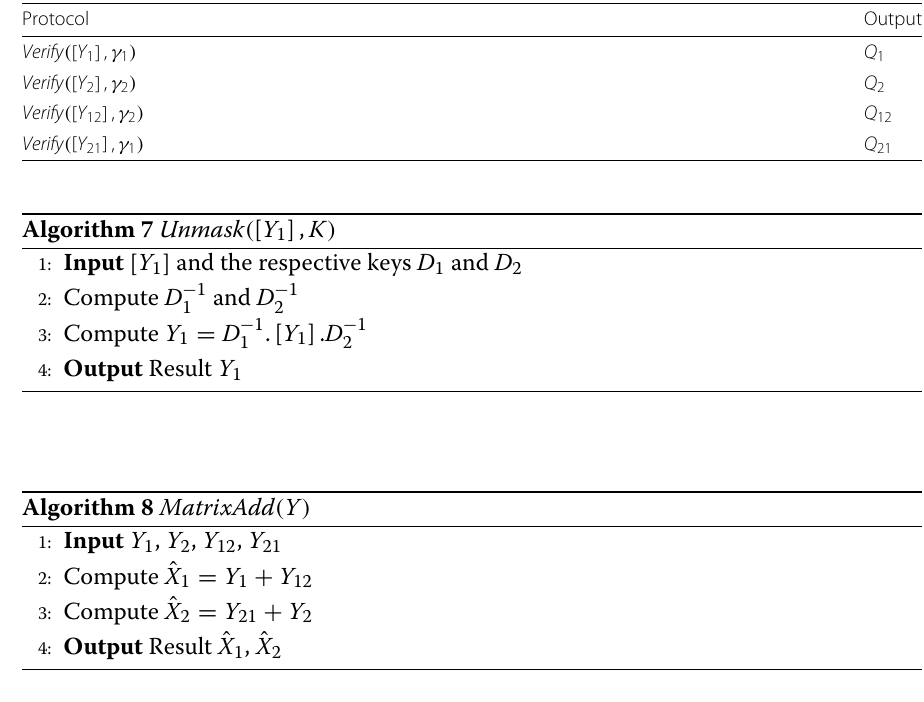
Table 4 Verification Protocol run by U per batch